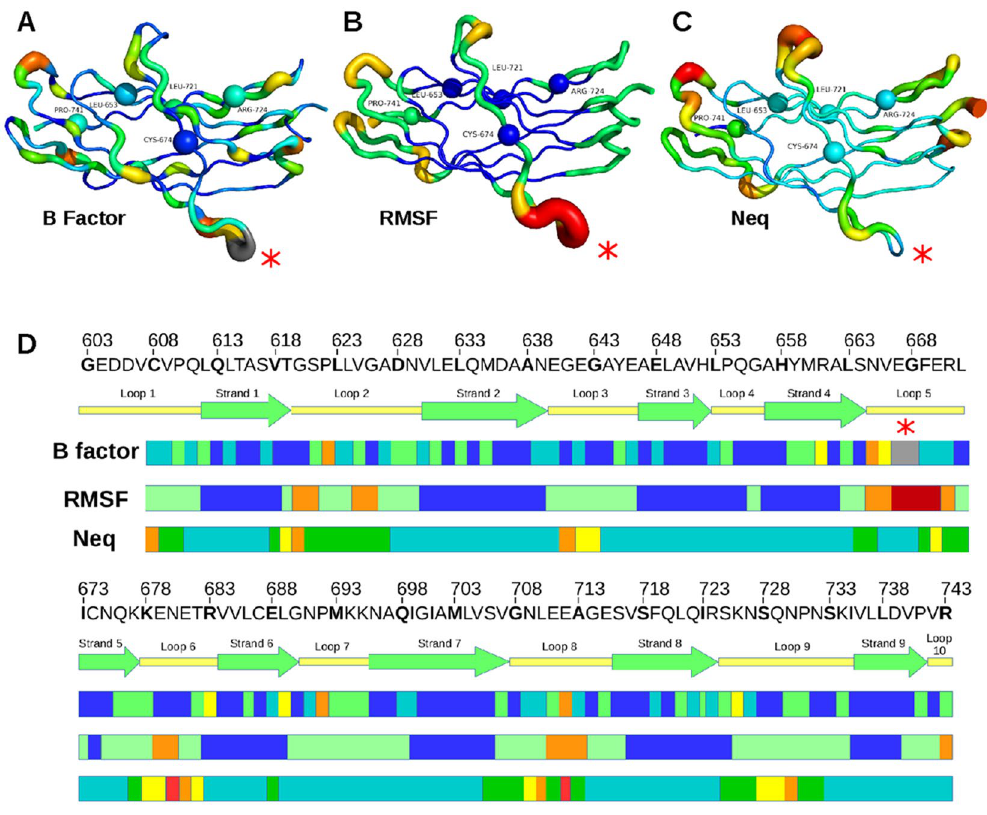
Figure 3. Comparison of the protein flexibility of Calf-1 through different metrics. 3D structures of Calf-1 domain represented through ( A ) B-factor values, ( B ) RMSF values, and ( C ) N eq values. Local structure is ranked from rigid (thin blue line, a value of 0.0) to flexible (thick red line, a value of 4.0). Residues with completed missing atoms are in grey in the B-factor cartoon ( A ). ( D ) The Calf-1 amino acid sequence is placed in regard to its secondary structures assignment and to protein flexibility according to the B-factor, the RMSF or the N eq values. Blue, green, yellow, orange and red colours scale the structure from rigid to flexible. The loops are: loop 1 (size: 9, positions 603–611), loop 2 (size: 10, positions 620–629), loop 3 (size: 7, positions 640–646), loop 4 (size: 4, positions 653–656), loop 5 (size: 8, positions 665–672), loop 6 (size: 6, positions 678–683), loop 7 (size: 6, positions 690–695), loop 8 (size: 8, positions 708–715), loop 9 (size: 11, positions 725–735), and loop 10 that begins at position